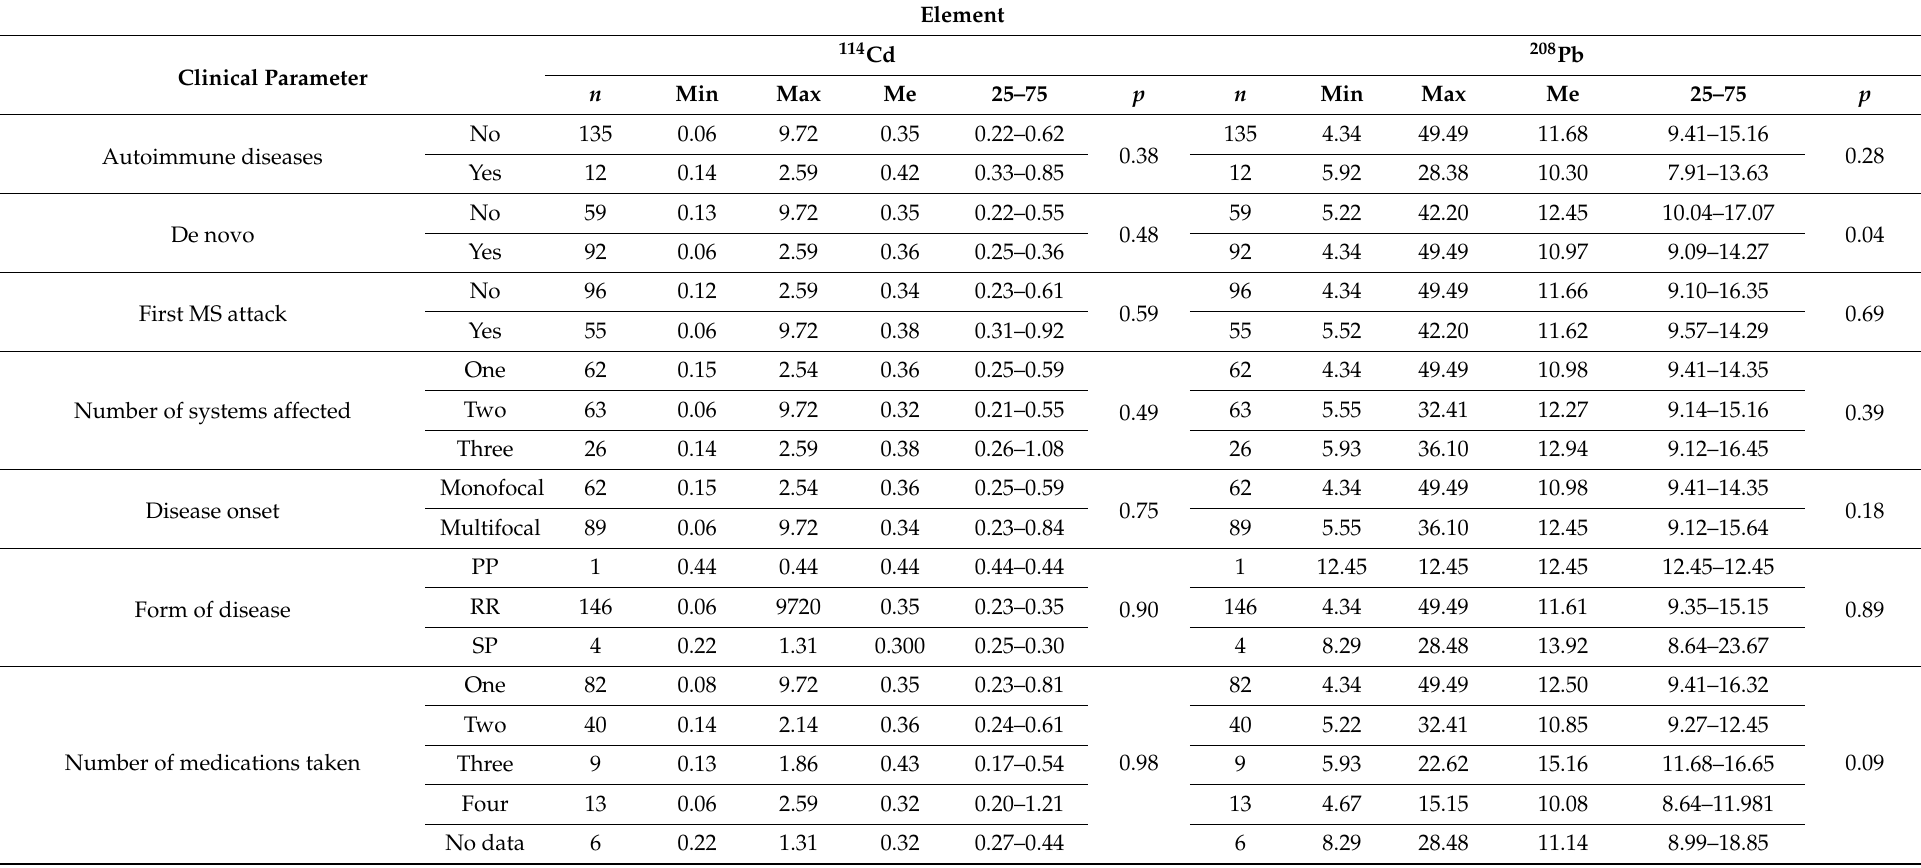
Table 4. Relationships between clinical parameters and the levels of the tested